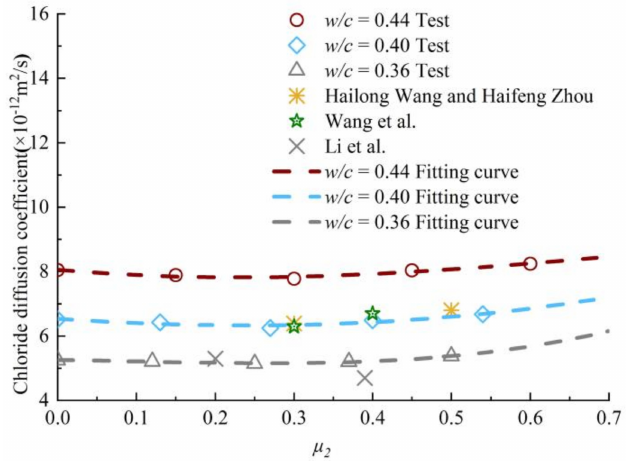
Figure 8. Experimental determination of chloride di ff usion coe ffi cient under uniaxial sustained compressive stress.